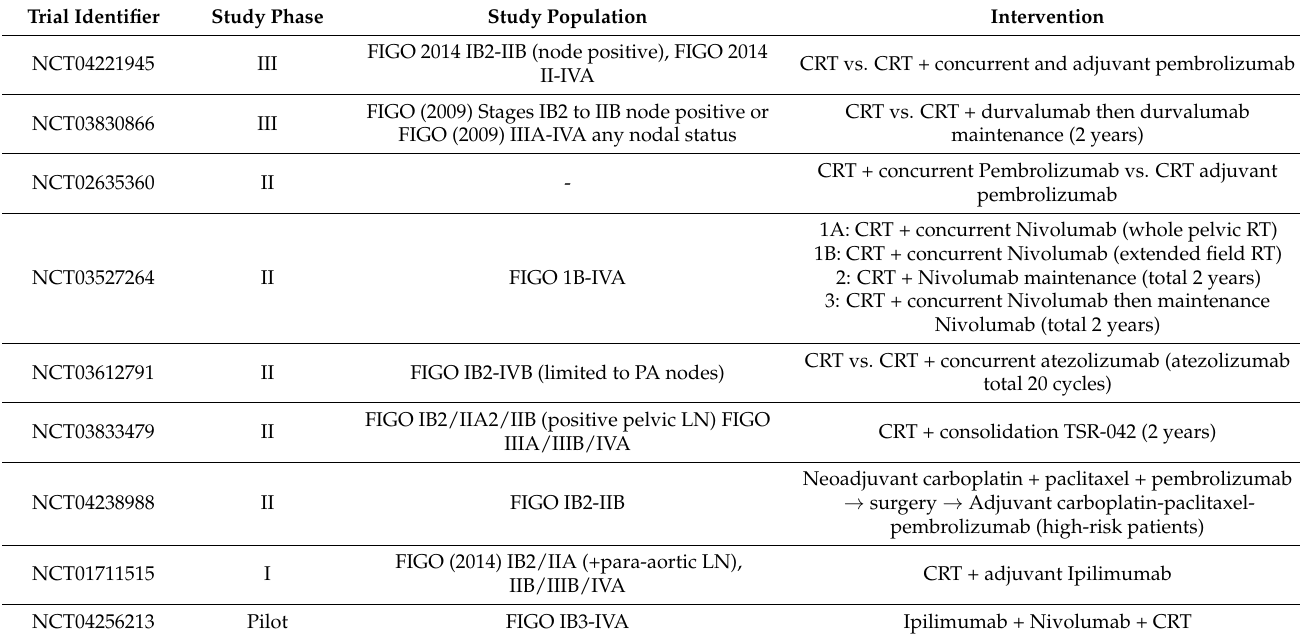
Table 2. Selected ongoing trials—Early/locally advanced cervical cancer.